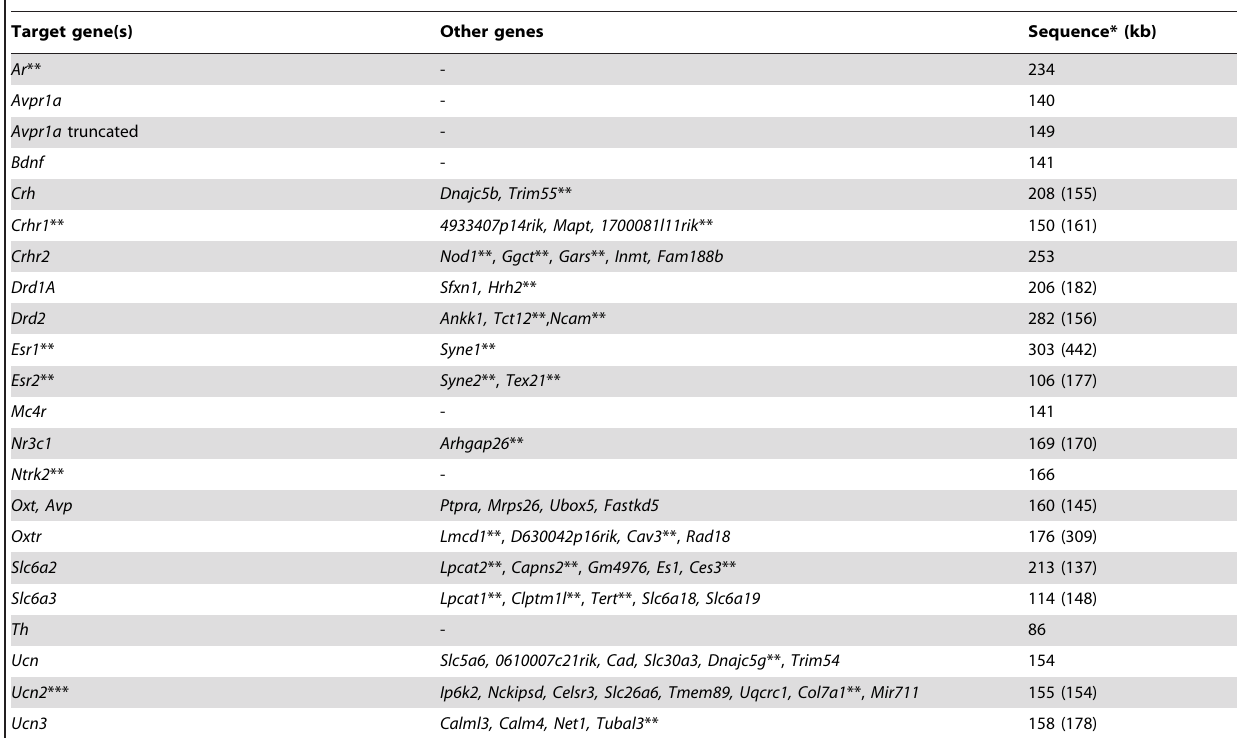
Table 2. Summary of BAC